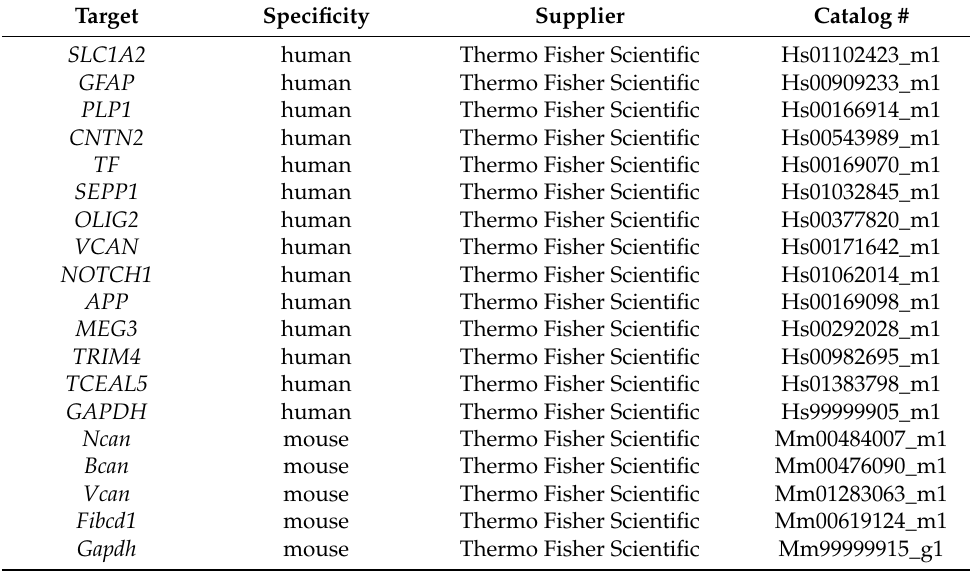
Table 5. Summary of qPCR primers used in this